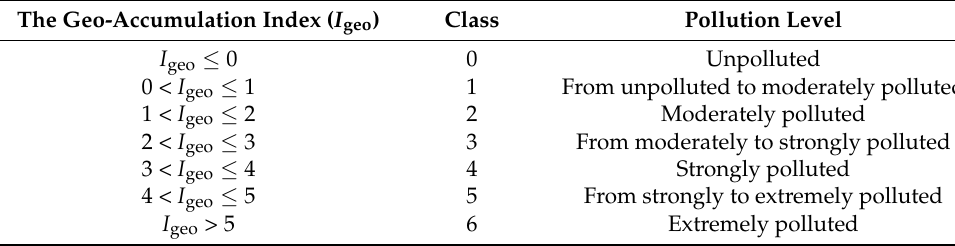
Table 1. The geo-accumulation index classification